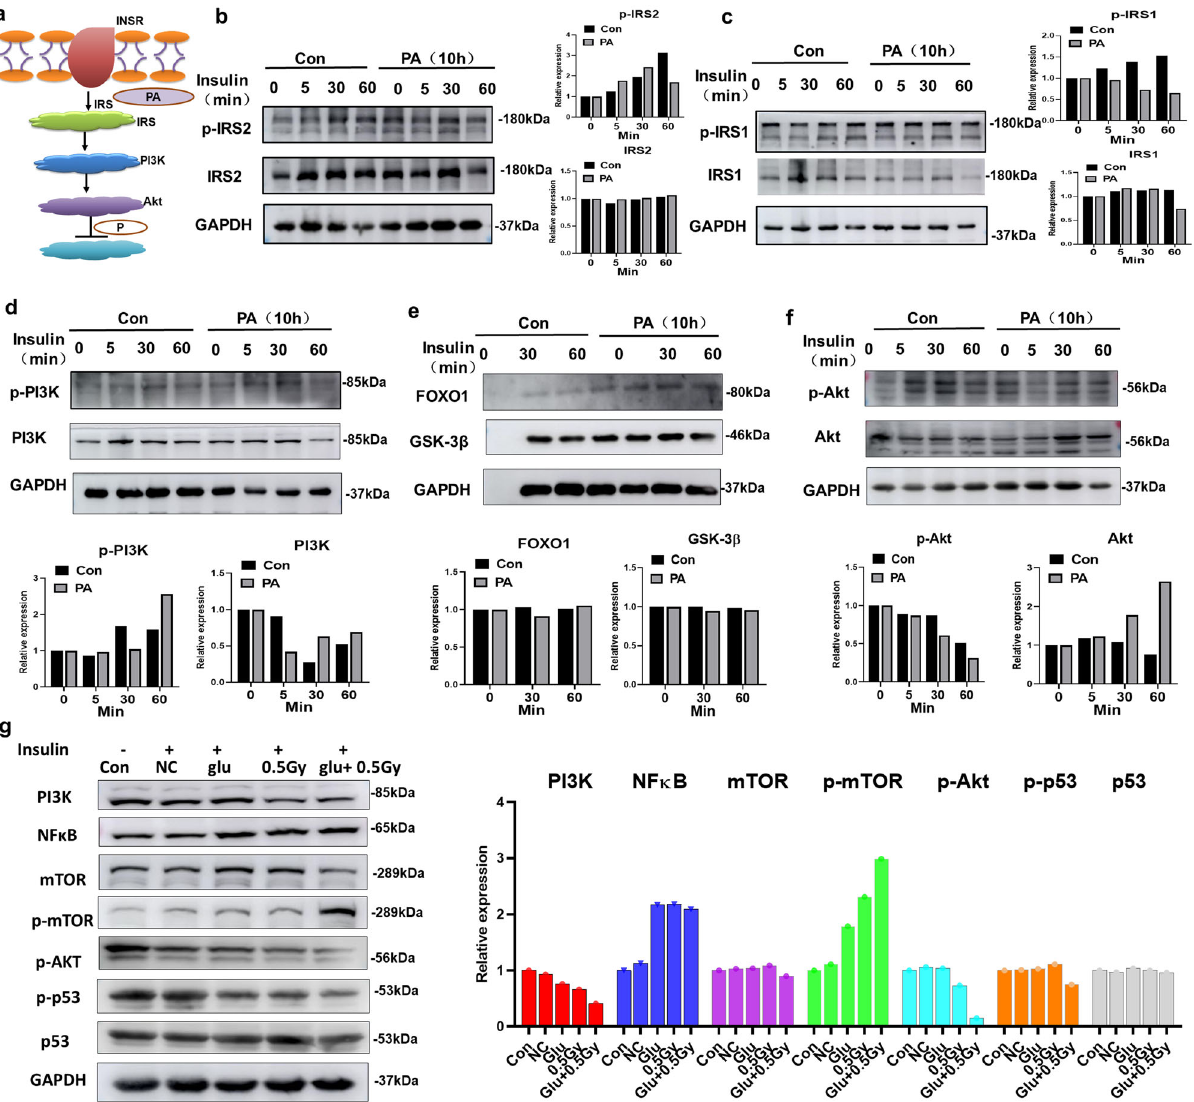
expression in HepG2 cells. d Western blot analysis (and quanti fi cation) of the effects of PA (100 μ M for 10 h) on insulin-stimulated p-PI3K